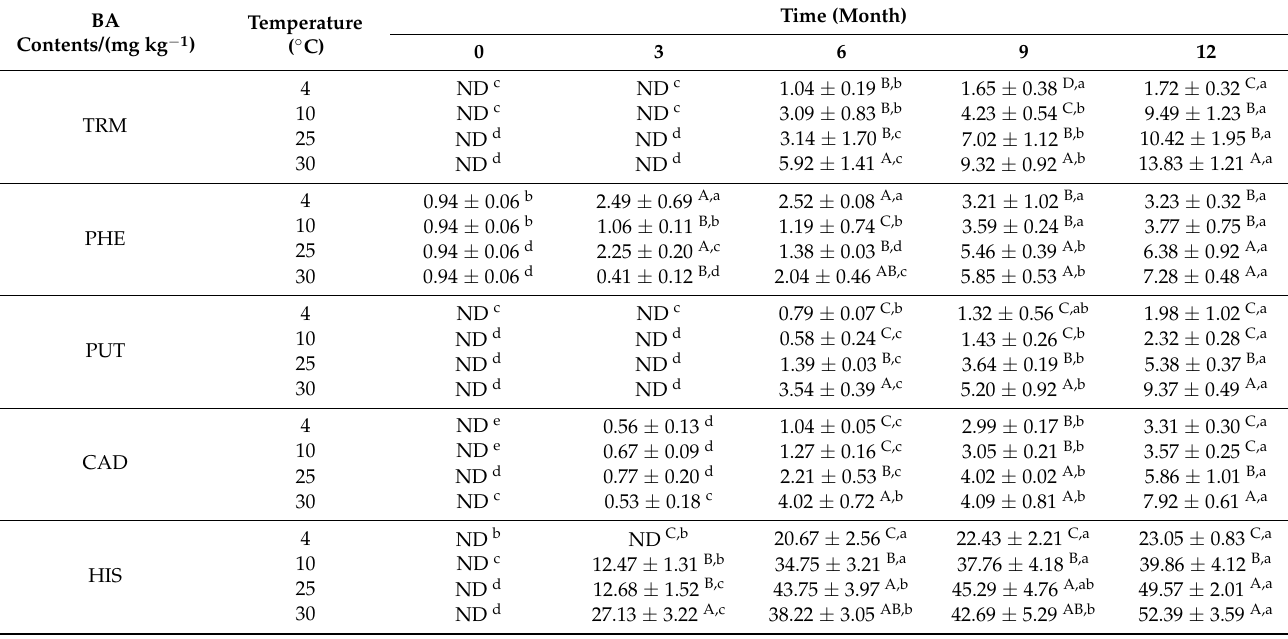
Table 4. Changes of BAs in canned scallop during storage at different